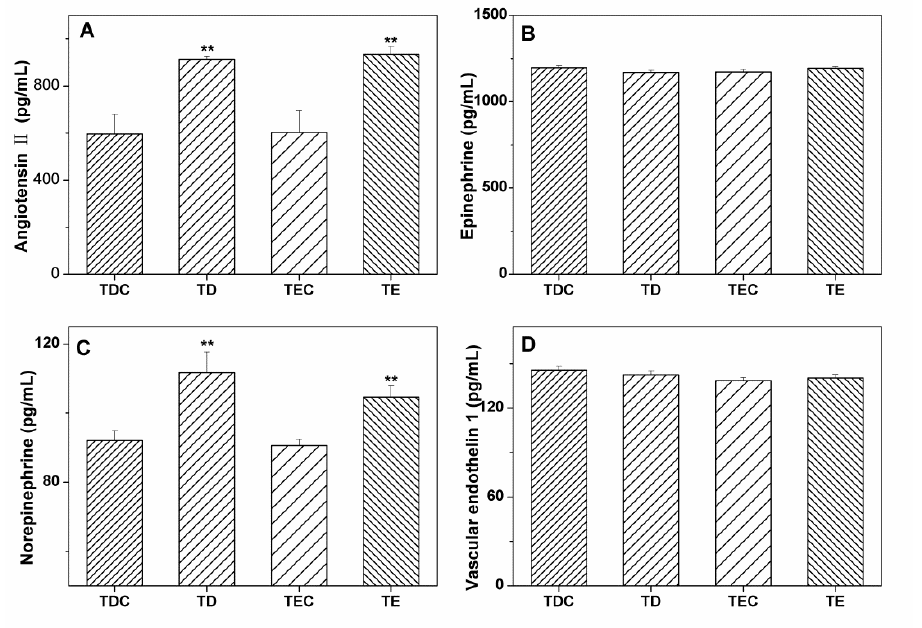
Figure 3. Effect of the temperature dropping process on plasma ANG II (A), EPI (B), NE (C), and ET1 (D) in Wistar rats. Results shown as a mean + SE, n = 6 in each group. Compared with the control group, ** P <